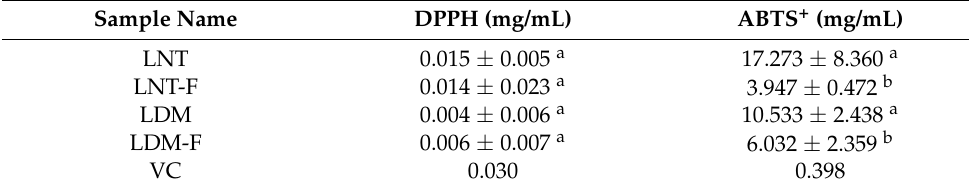
Figure 6. Antioxidant activity of fermented and unfermented lentinan: ( A ) DPPH free radical scavenging ability; ( B ) ABTS + free radical scavenging ability; ( C ) Ferric-reducing antioxidant power (FRAP). Table 4. Fermented and unfermented lentinan 50% inhibitory activity on antioxidant